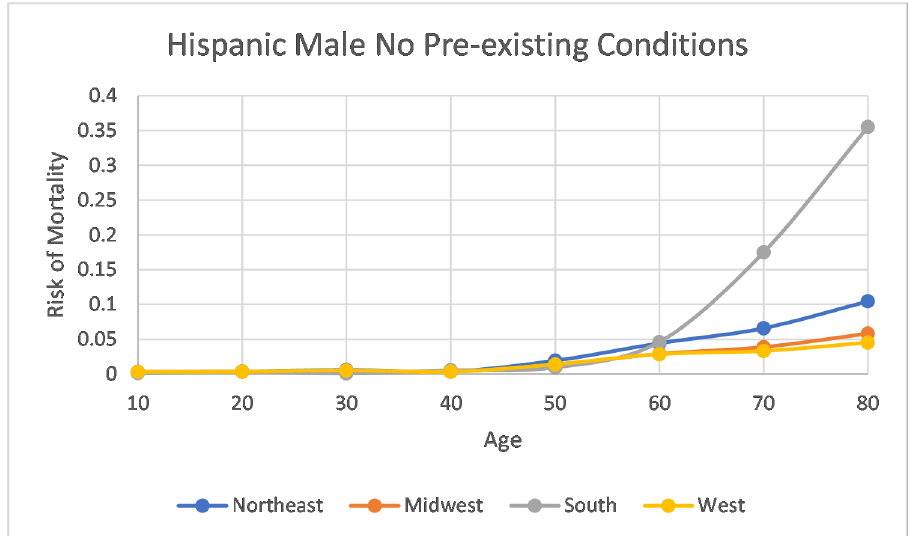
Figure 9. Probability of mortality for a Hispanic male with no pre-existing conditions for certain age groups. Given as a decimal. Same information as in Table 10.